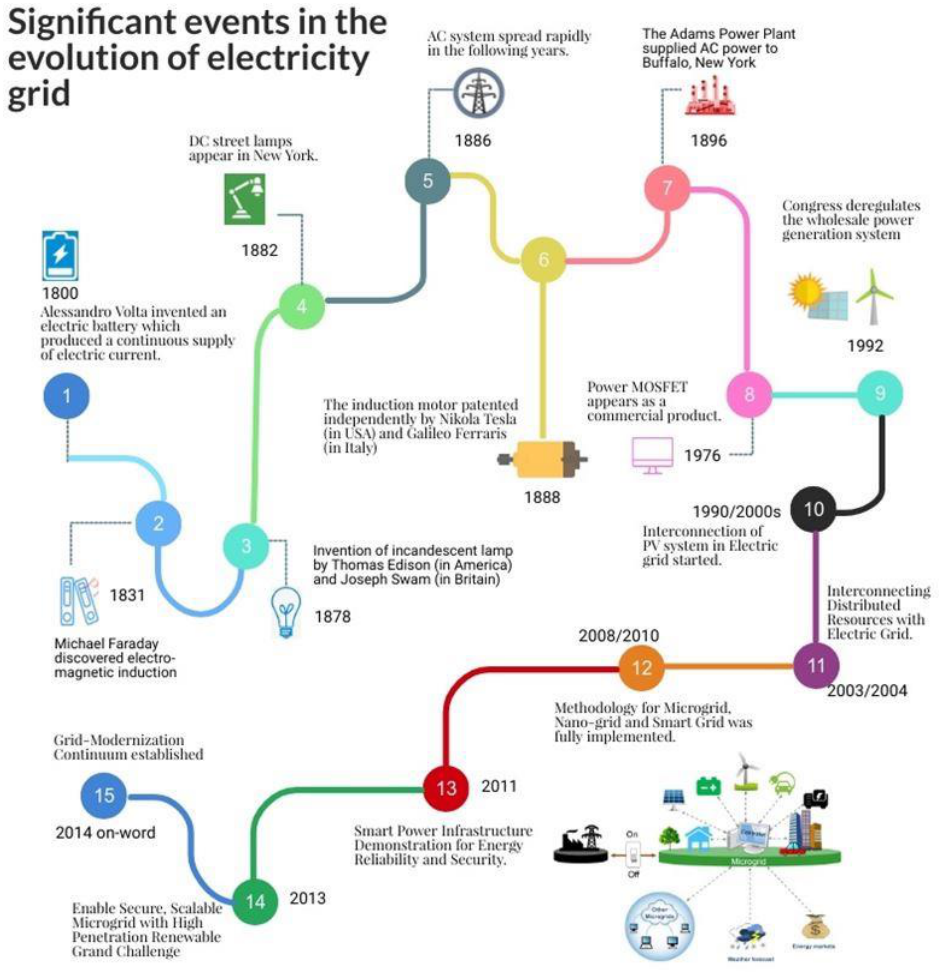
Figure 1. Fifteen most significant events in the evolution of the electricity grid (Note: DC—direct current, AC—alternating current, USA—United States of America, MOSFET—metal-oxide-semiconductor field-effect transistor).